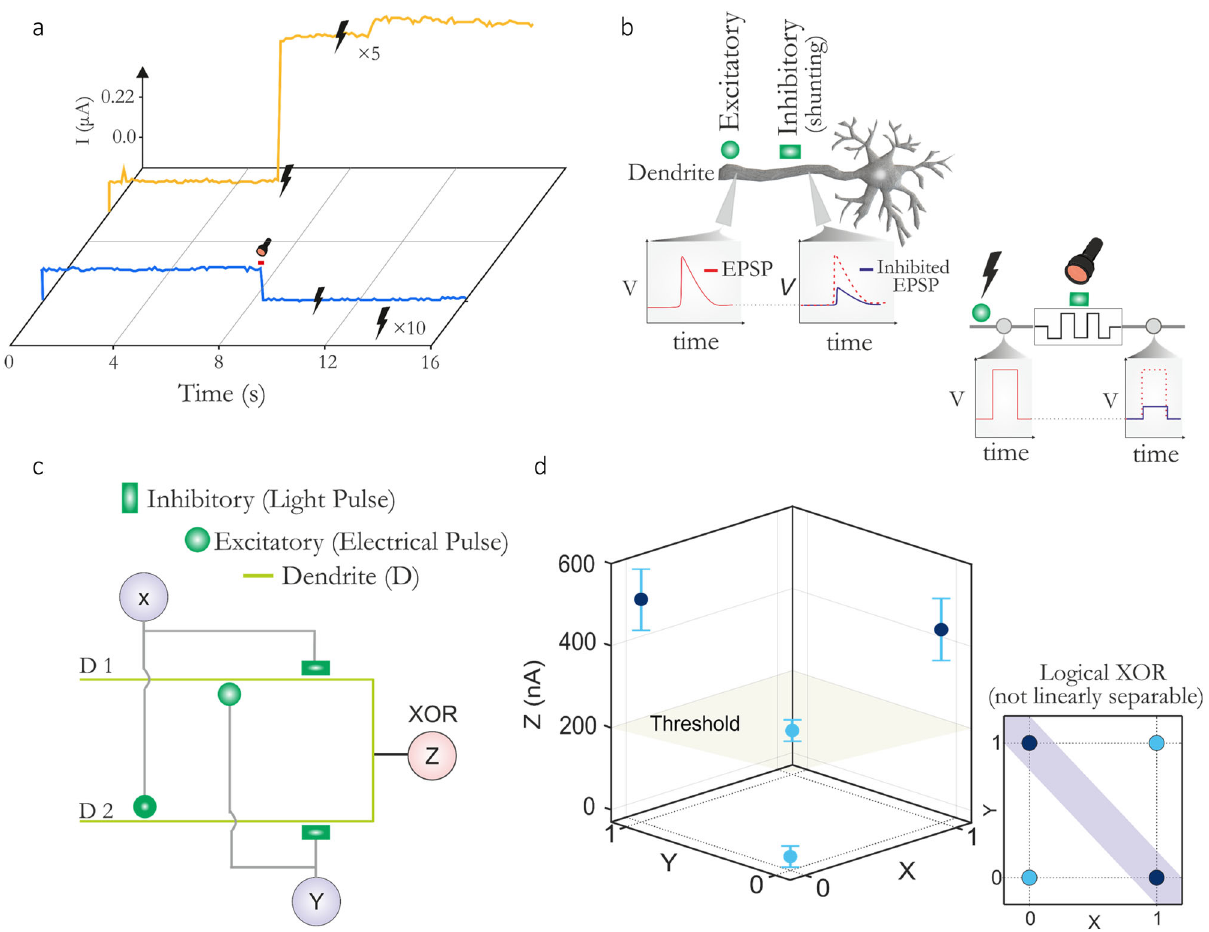
Fig. 4 Shunting inhibition and single-neuron implementation of XOR. A A volatile Pt/GeSe 3 /Ag device under a mixed mode operation. In the absence of light (yellow trace), electrical pulses applied to the device induce a switching event, while the presence of light inhibits device switching. B Sketch of a biological neuron. Shown is a single dendrite of the neuron possessing an excitatory synapse and, proximally to the neuron ’ s soma, a synapse capable of shunting inhibition. Each excitatory input generates an EPSP (red trace) that propagates, but its effect is gated by inhibitory inputs. An input to the shunting inhibitory synapse attenuates the EPSP (blue trace), but in the absence of excitation, it has no effect (not shown). A volatile type memristive device emulates this dendrite, with the excitatory and shunting inhibitory inputs applied by electrical and optical stimulation respectively. C A neuron (Z) comprising two distinct dendrites (D1 and D2) that receive inputs from neurons X and Y. Each dendrite has an excitatory and a shunting input synapse and functionally emulates the biological counterpart shown in B . D Results of Z ’ s output for different input pairs. Errorbars represent the mean of multiple measurements. Owing to the memristive dendrites, neuron Z realizes an XOR gate, a function that is impossible for a single layer of point neurons.